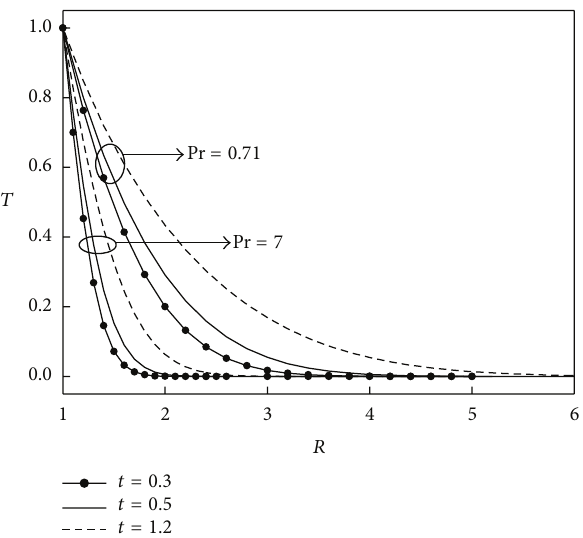
Figure 8: Concentration profiles with respect to time for different values of K and Sc at 𝑅 = 1.5 .